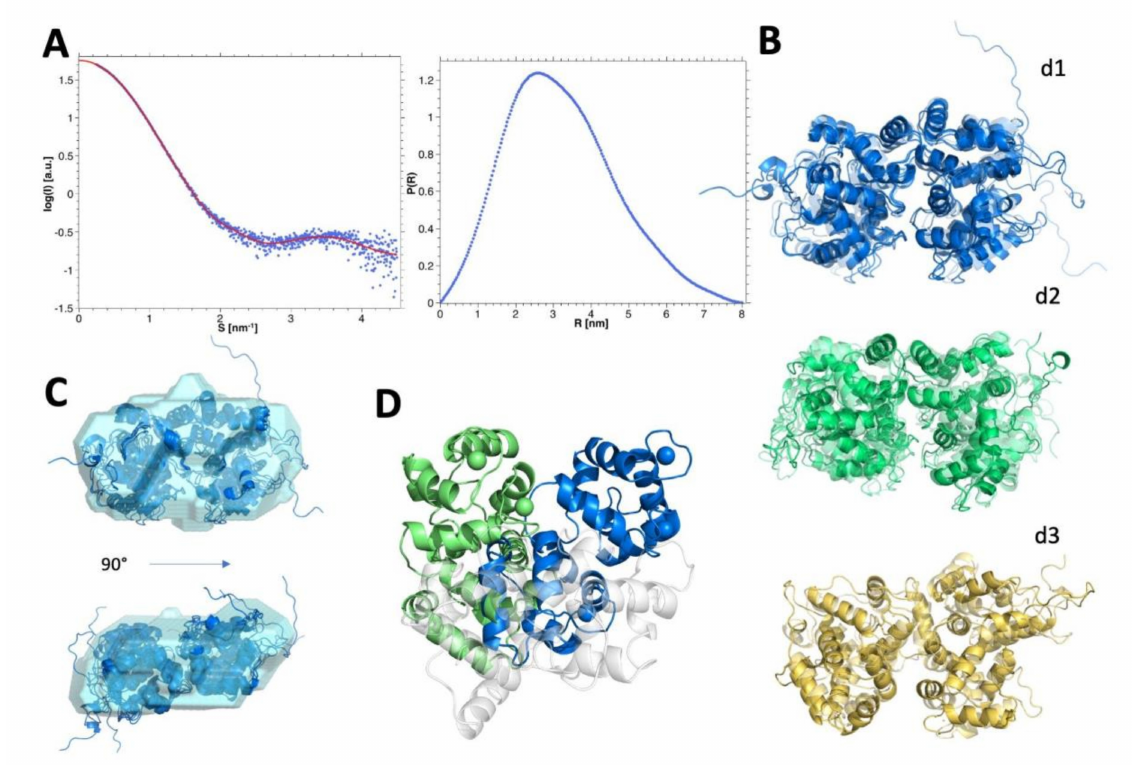
Figure 5. SEC-SAXS data of hGCAP1 dimer. ( A ) GNOM fitting (red line) of the SEC-SAXS data (blue points) at the higher protein concentration and corresponding P(R). ( B ) Dynamical EOM models of the 3 dimeric assemblies—d1-d3—in cartoons with transparency depending on the occupation of each structure on the assembly. ( C ) Superposition of the dynamical model d1 (blue cartoon) on one of the most representative low-resolution models (DAMMIF, P2 symmetry, ensemble resolution = 29 ± 2 Å, NSD 1.67) depicted as the cyan surface in 2 di ff erent orientations. ( D ) Di ff erent orientation of the monomers d1 (cid:48) —blue cartoons and d2 (cid:48) —green cartoons in the static dimeric assemblies (the superposed monomer is shown as white transparent